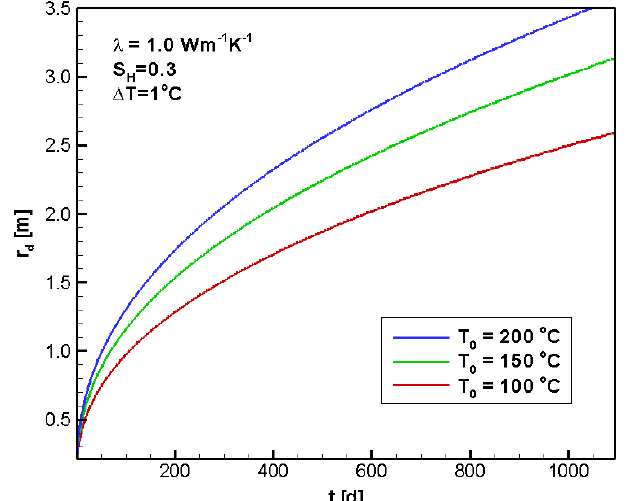
Figure 7. Evolution of hydrate dissociation radius and its sensitivity to bottom-hole